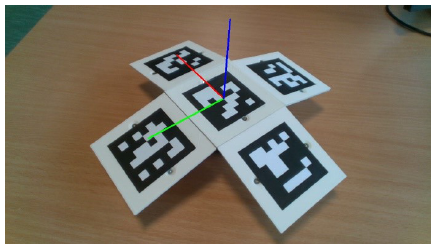
Figure 2. Aruco 3D gridboard with detected coordinate frame XYZ—red, green, blue,